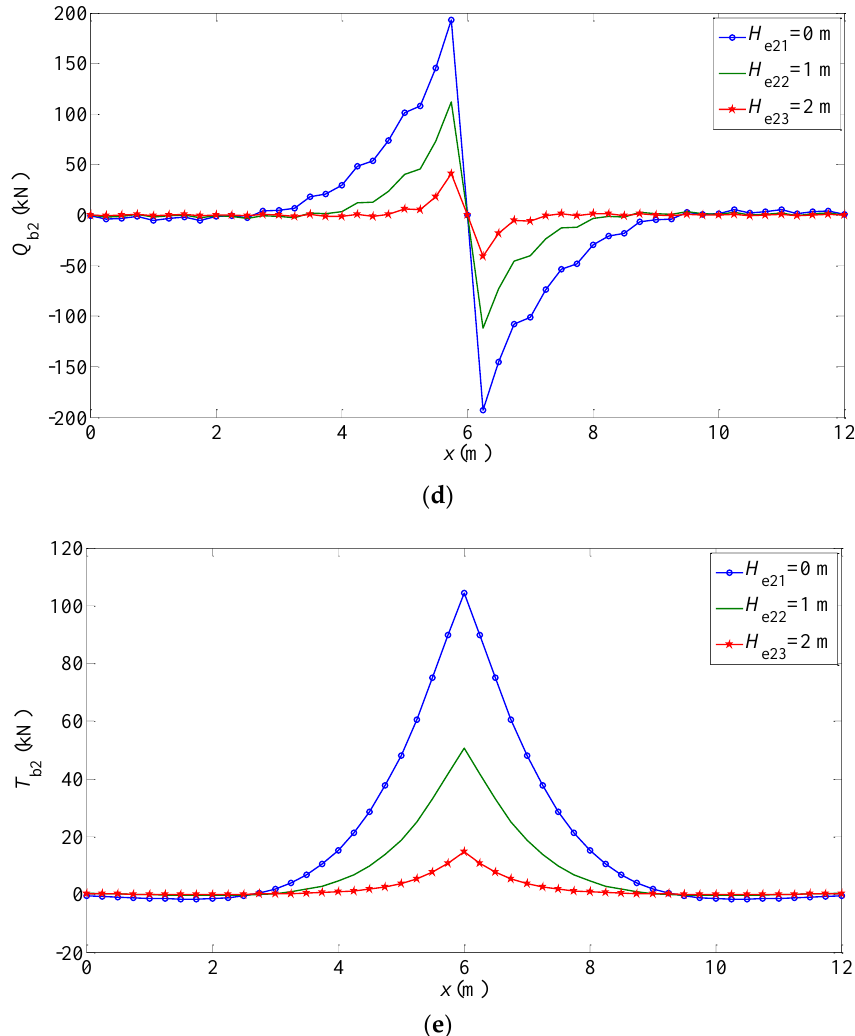
Figure 8. Results for a beam embedded in a transversely isotropic foundation ( E T 22 = 57.6 MPa). ( a ) Displacement of a beam embedded in a transversely isotropic foundation ( E T 22 = 57.6 MPa); ( b ) rotation angle of a beam embedded in a transversely isotropic foundation ( E T 22 = 57.6 MPa); ( c ) bending moment of a beam embedded in a transversely isotropic foundation ( E T 22 = 57.6 MPa); ( d ) shear force of a beam embedded in a transversely isotropic foundation ( E T 22 = 57.6 MPa); ( e ) subgrade force of a transversely isotropic foundation ( E T 22 = 57.6 MPa). The calculation results for different cases are given in Tables 4 and 5, including the displacement w at the center, reaction coefficient k 2 , shear coefficient G p 2 , and characteristic coefficient φ 2 ( H e ) . With the increase in the embedment depth, the displacement and characteristic coefficient decrease. However, as the embedment depth increases, the reaction coefficient and shear coefficient remain constant, which is different from the variation law of Gibson soils in Example 2. In addition, it can be seen from these tables that when the modulus E T 2 of elasticity in the normal direction of the isotropic plane increases, the two parameters (reaction coefficient and shear coefficient) become